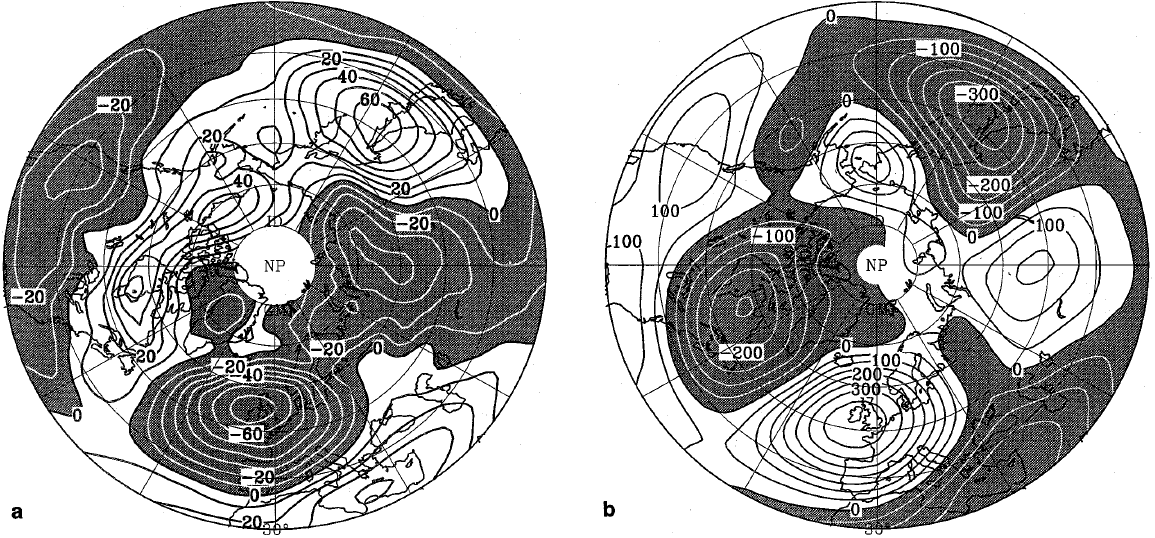
Fig. 1a, b. Disturbance, March 1997 a total ozone by Adeos TOMS. D O3* = 10 DU b geopotential (300 hPa), D G * = 50 gpm. Shaded area :